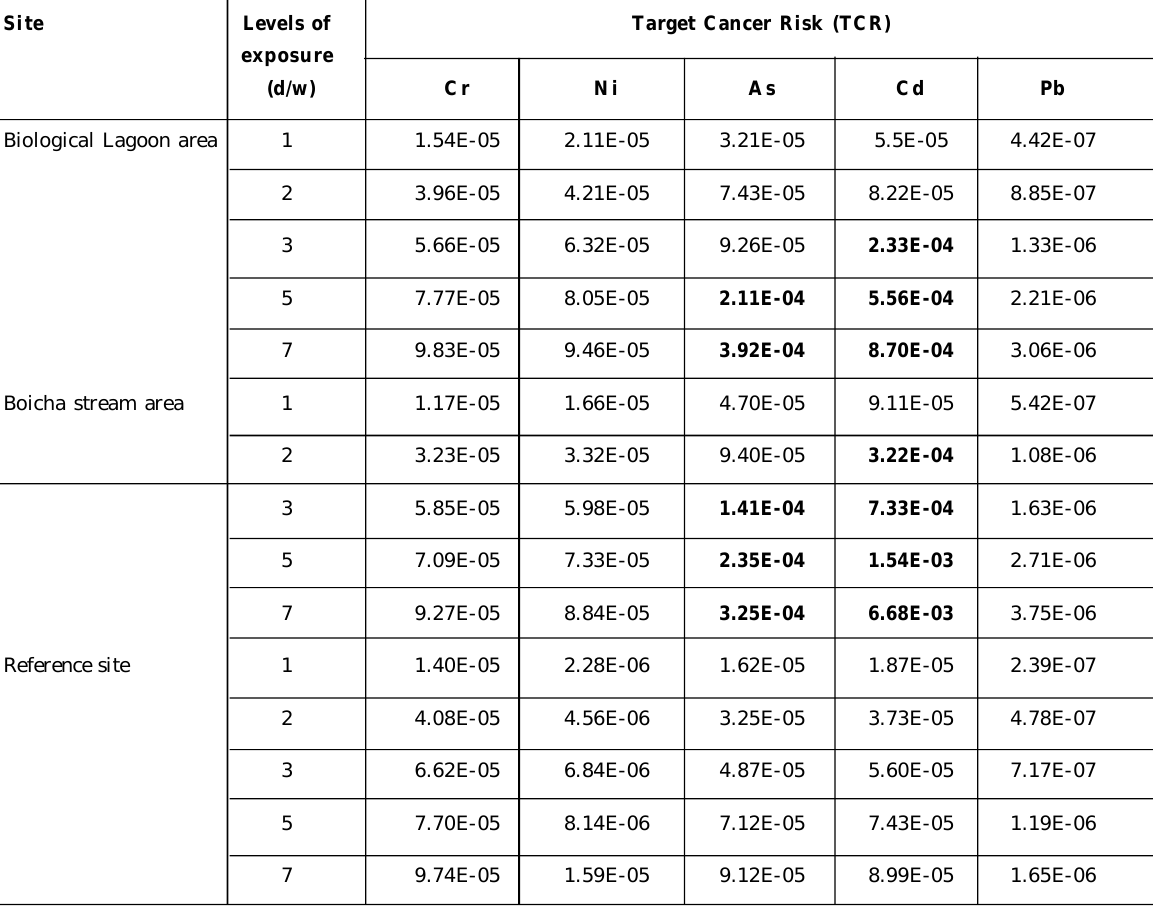
Table 4: Carcinogenic (TCR) health risks of heavy metals due to consumption of cabbages from the study sites Site